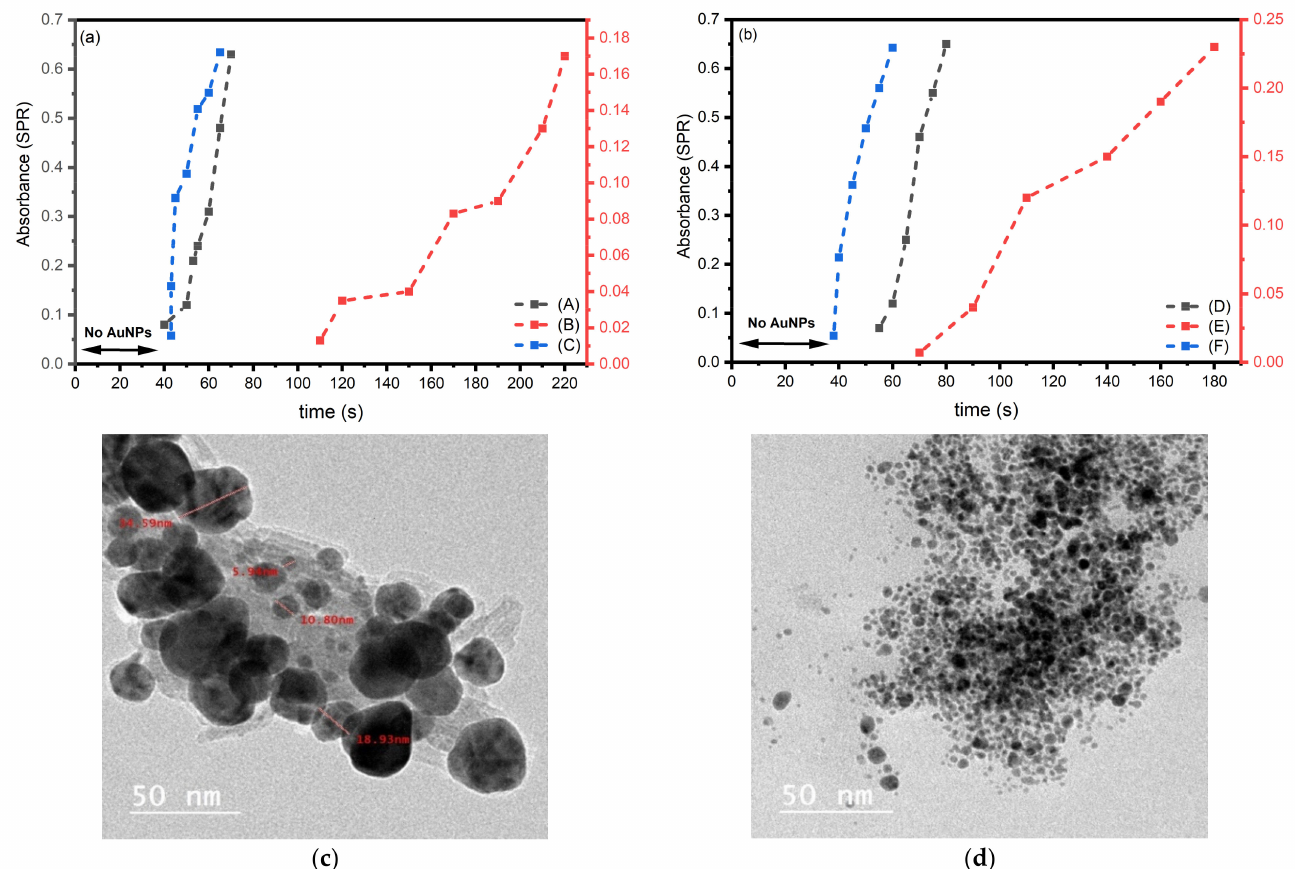
Figure 4. Plots of comparison between the PIS system based on R3 0.2 wt%/TEA 0.2 wt%/HAuCl 4 3 wt% (A), on R3 0.2 wt%/Iod 1 wt%/HAuCl 4 3 wt%(B) and the PIS system based on R3 0.2 wt%/TEA 0.2 wt%/Iod 1 wt%/HAuCl 4 3 wt% solution(C) ( a ), and the PIS system based on R4 0.2 wt%/TEA 0.2 wt%/HAuCl 4 3 wt% (D), on R4 0.2 wt%/Iod 1 wt%/HAuCl 4 3 wt%(E) and the PIS system based on R4 0.2 wt%/TEA 0.2 wt%/Iod 1 wt%/HAuCl 4 3 wt% solution (F) ( b ). TEM micrographs of gold nanoparticles of the PIS system based on R3 0.2 wt%/TEA 0.2 wt%/Iod 1 wt% solution ( c ) and the R4 0.2 wt%/TEA 0.2 wt%/Iod 1 wt% solution ( d